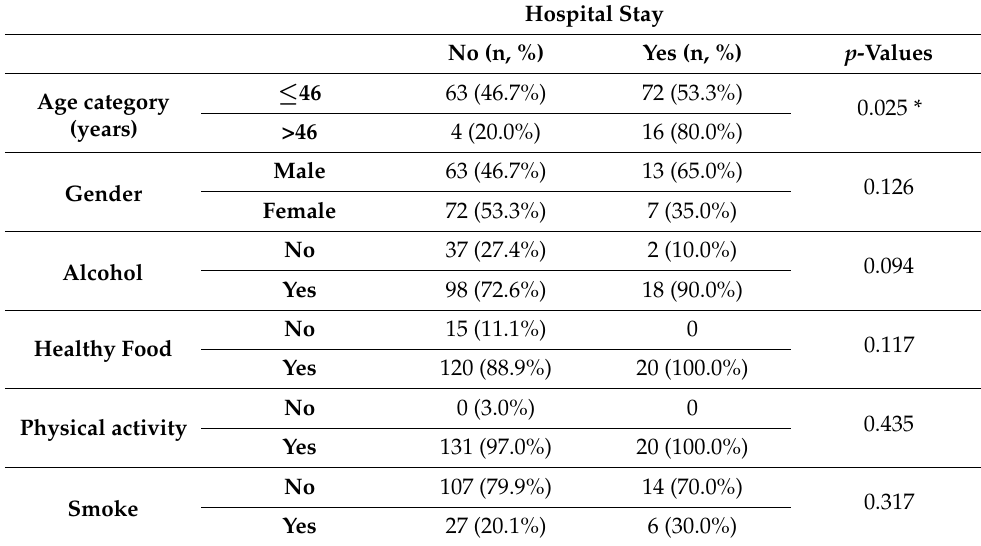
Table 3. Chi-square test correlating age, gender, and modifiable risk factors, with hospital stay (* p ≤